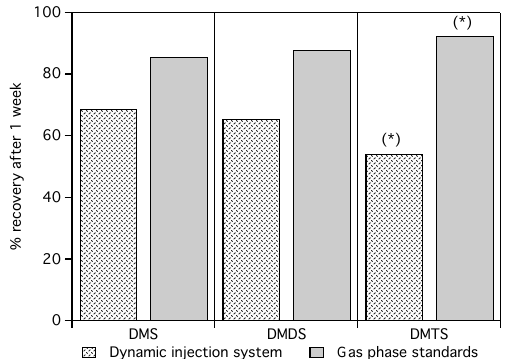
Figure 4. Recovery of DMS, DMDS, and DMTS in elec- tropolished stainless steel canisters after 1 week. Data include measurements made from the dynamic injection system (mot- tled bars; [DMS] ∼ 21ppb; [DMDS] ∼ 20ppb; [DMTS] ∼ 33ppb) and from a gas-phase source (gray bars; [DMS] ∼ 140ppb; [DMDS] ∼ 131ppb; [DMTS] undetermined). The asterisks corre- spond to DMTS samples where DMDS was observed in the canister after 1 week, suggesting that DMTS decomposed on the surface of the